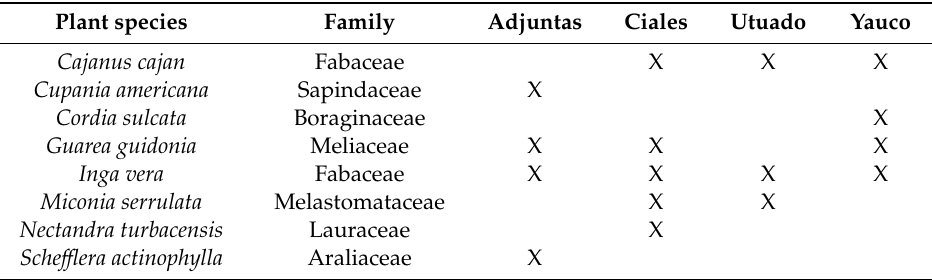
Table 2. Plant species with perforated fruits evaluated as potential alternate hosts, and their distribution on the co ff ee farms